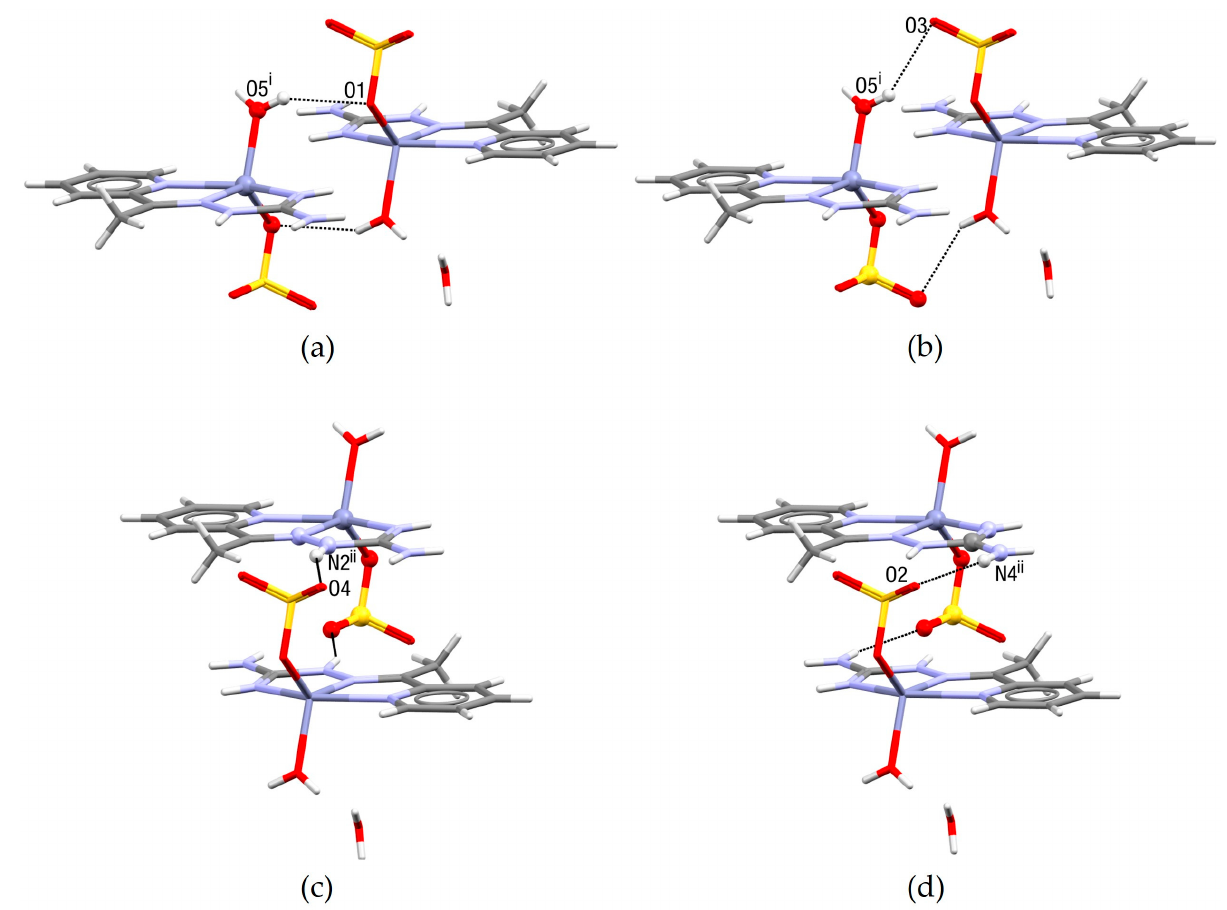
Figure 5. Ring-type graph sets describing the hydrogen bonds between [Zn(L)H 2 O(SO 4 )] molecules: ( a ) 𝑅 (cid:2870)(cid:2870) (8) ; ( b ) 𝑅 (cid:2870)(cid:2870) (12) ; ( c ) 𝑅 (cid:2870)(cid:2870) (14) ; ( d ) 𝑅 (cid:2870)(cid:2870) (16) . Symmetry codes (i) − x + 1, − y + 1, − z + 1; (ii) − x , − y + 1, − z + 1.